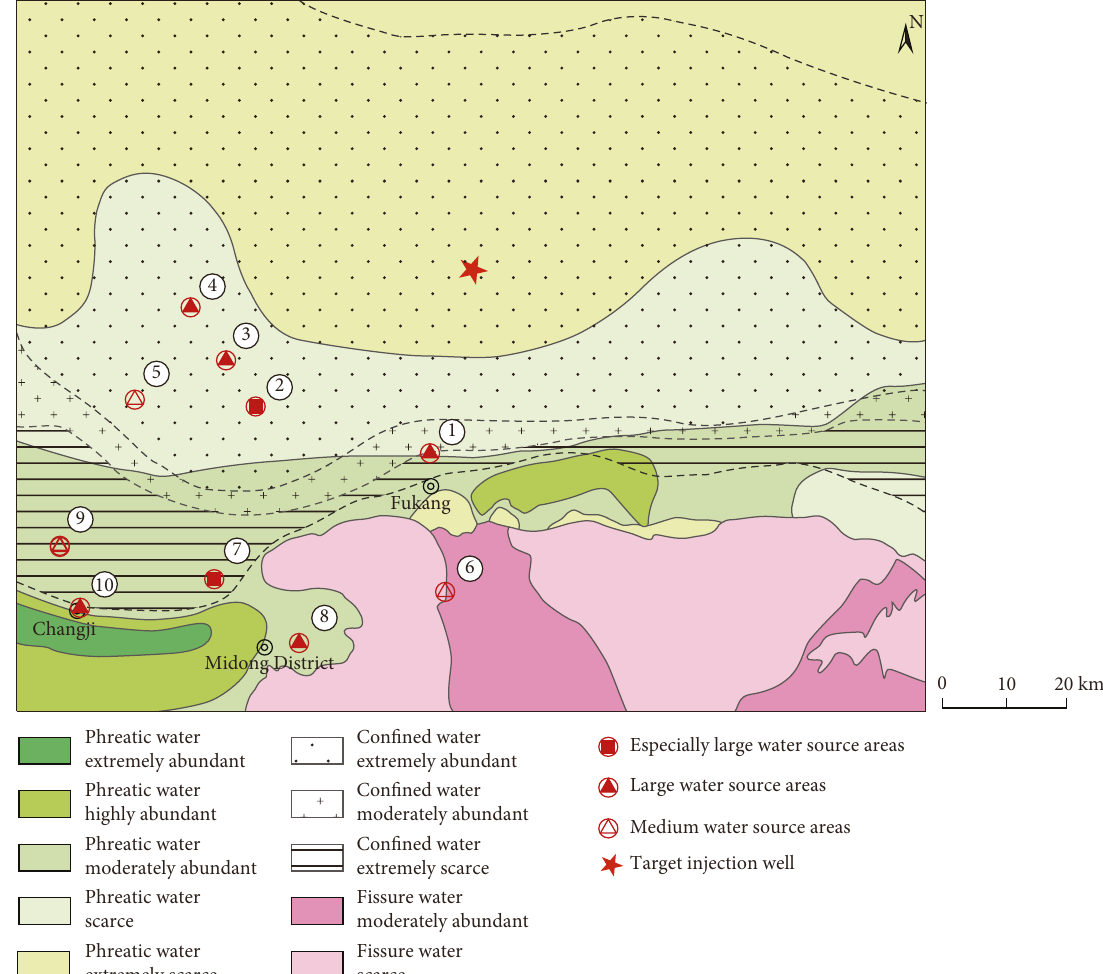
Figure 5: Hydrogeological conditions and distribution of groundwater sources in the study